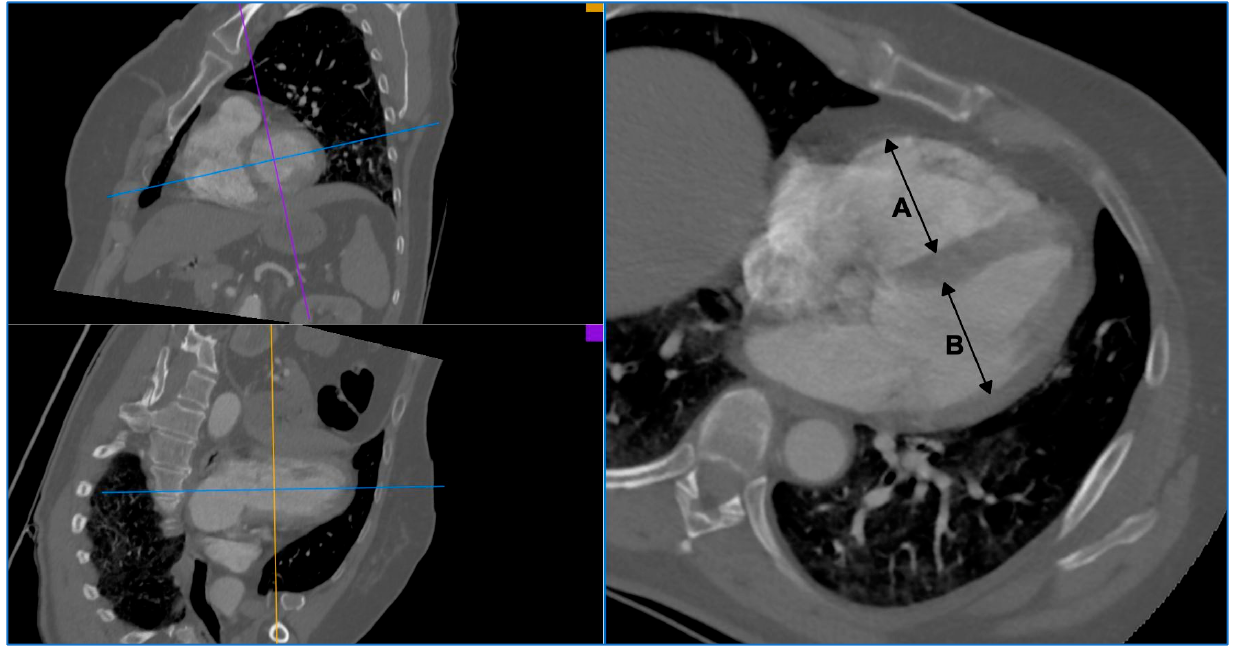
Figure 2. An example of RV/LV ratio measurement in CTA of pulmonary arteries. A: right ventricle diameter, B: left ventricle diameter.